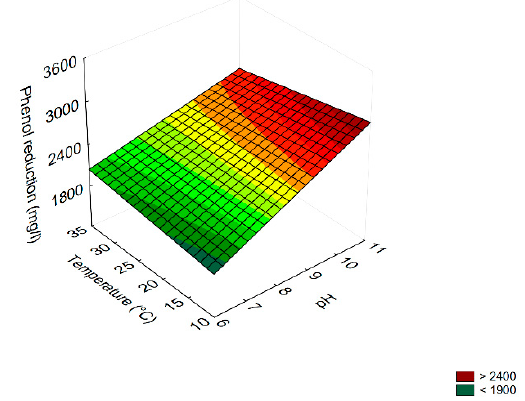
Figure 5. Surface response plot for the interaction Temperature/pH on phenol reduction by T. harzianum .